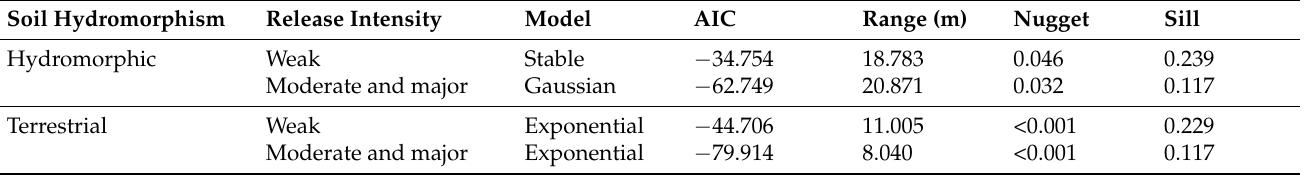
Figure 5. Summary disturbance histories of Boubin, developed separately for: ( A ) terrestrial and ( B ) hydromorphic soils. Upper charts represent the proportion of disturbed canopy area (%) from the total sum of exposed canopy (sample depth, m 2 ) in the examined decade. Bottom charts depict the number of trees indicating gap origin. Table 3. Characteristics of spatial autocorrelation for the best-fitting models. Range represents the distance beyond which observations are not spatially autocorrelated, ecologically interpreted as the diameter of the canopy gap. The nugget is referred to small-scale variation at the beginning of a model as a result of site variability or measurement error. The sill express the maximal variance of data set that is not spatially